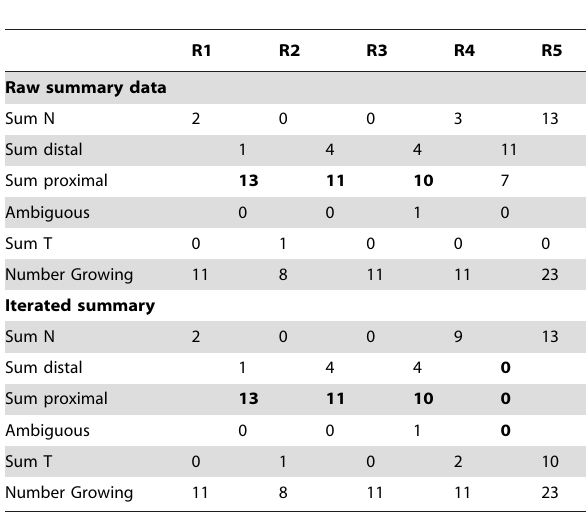
Table 6. Molt summary for the rectrices in adult Hemiprocne mystacea